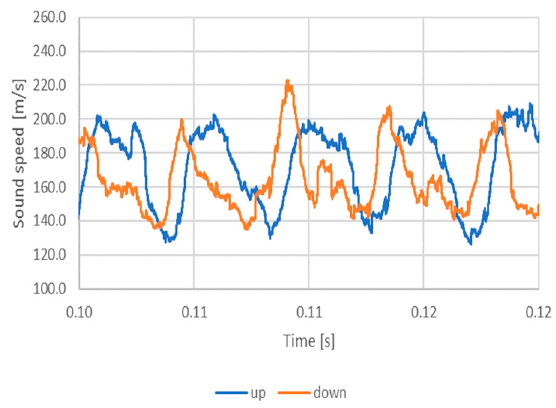
Figure 3. Sound speed vs. time in a generic section of the pipe, damper inactive.